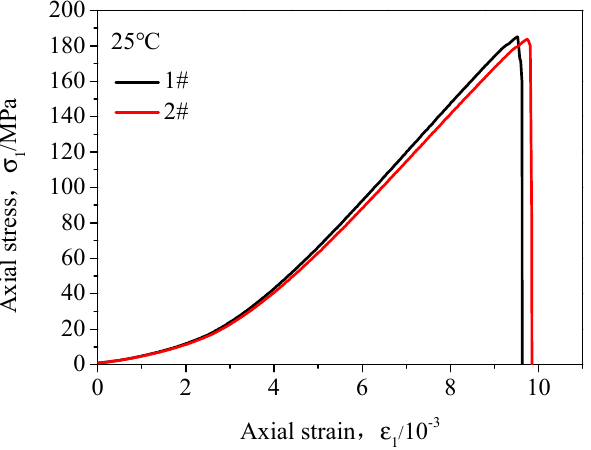
Figure 5. Stress-strain curve of intact granite at 25 °C.